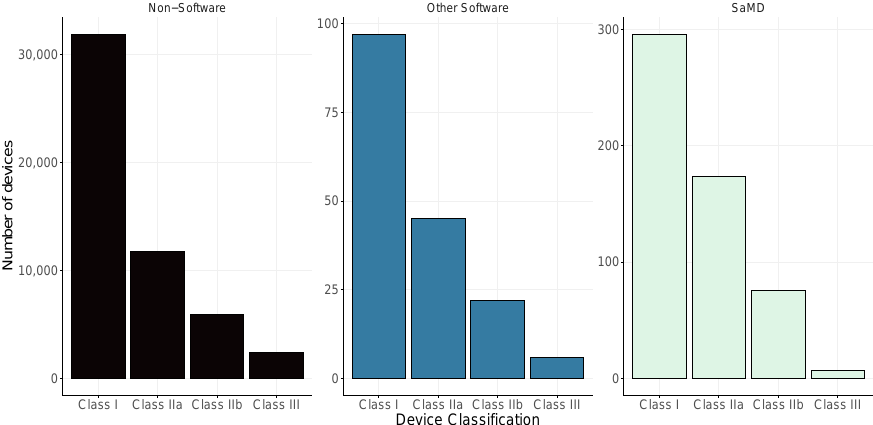
Figure 3. Comparison of device classification between software-as-a-medical-device (SaMD), other software and non-software. Please note the difference in scales for each of the